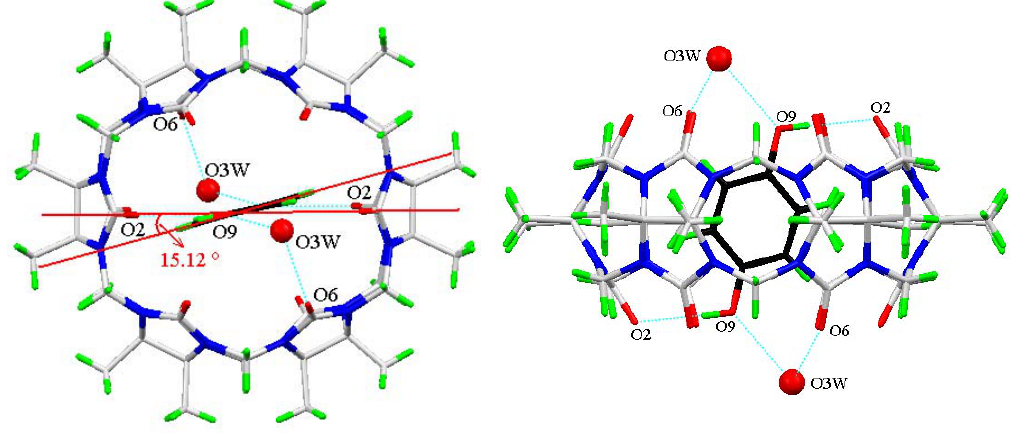
Figure 2. Crystal structure of the inclusion host-guest complex of DDMeQ[6]-DHOBEN, showing partial atomic numbering and drawn at the 50% probability level in top view(left) and side